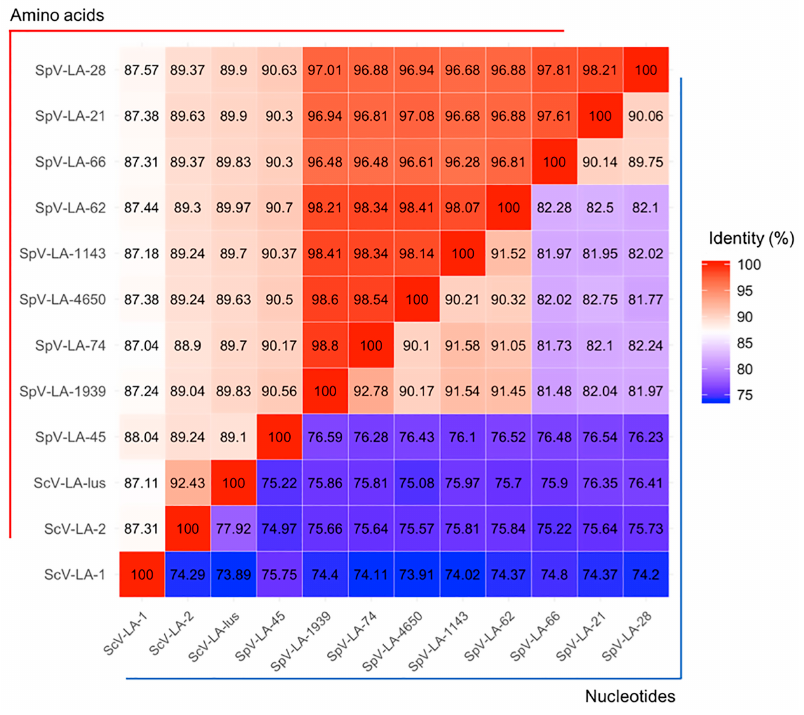
Figure 1. The similarities of S. cerevisiae and S. paradoxus dsRNA L-A virus-encoded Gag-pol proteins. ORFs coding for the Gag-pol proteins were compared with corresponding fragments of S. cerevisiae and S. paradoxus dsRNA sequences, namely: GenBank entry J04692 for the ScV-LA-1 virus, KC677754 for ScV-LA-2, and JN819511 for ScV-LA-lus, KU845301 for SpV-LA-28 (formerly attributed to S. cerevisiae ), KY489962 for SpV-LA-21, KY489963 for SpV-LA-45, KY489964 for SpV-LA-74, KY489965 for SpV-LA-4650, KY489966 for SpV-LA-1939, KY489967 for SpV-LA-1143, KY489968 for SpV-LA-62. Identity at nucleotide level is represented in the lower right triangle, amino acid level–in the upper left triangle, framed by corresponding blue and red